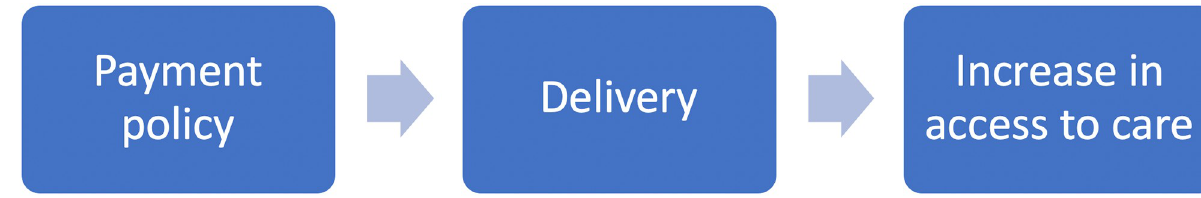
Fig 1. Telehealth research